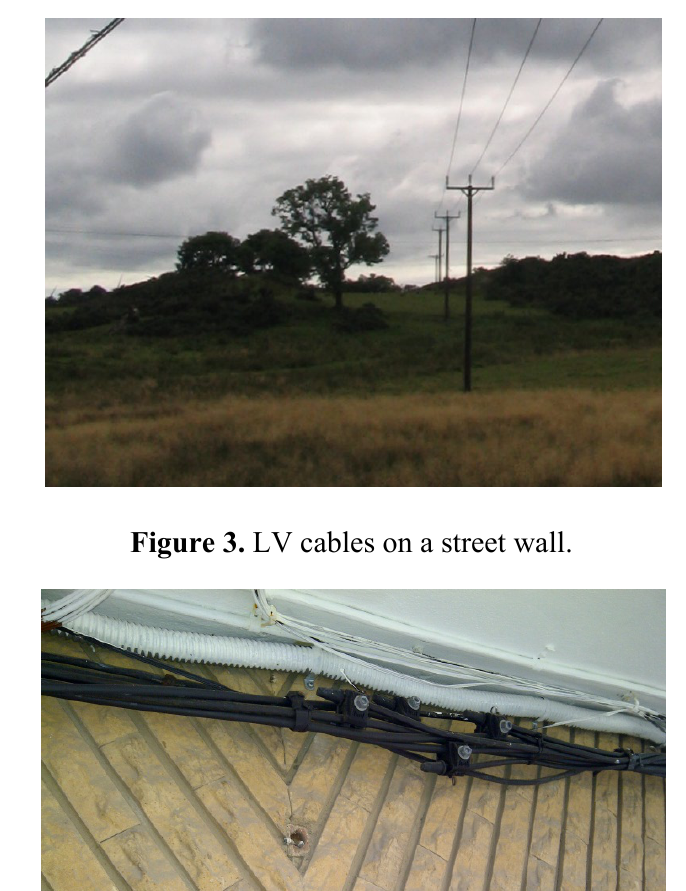
Figure 2. Medium voltage (MV) cables on poles.